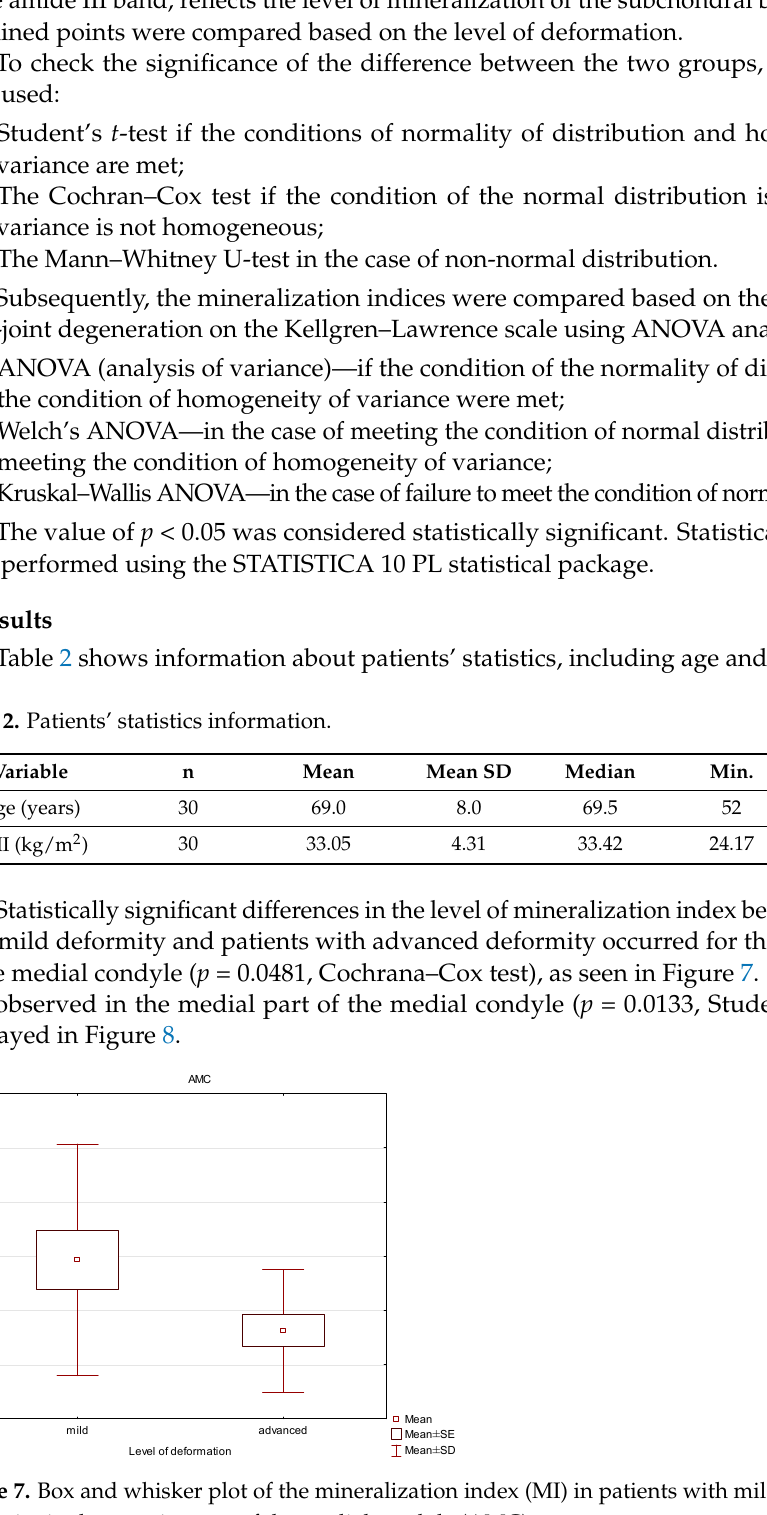
Figure 8. Box and whisker plot of the mineralization index (MI) in patients with mild and advanced deformity in the medial part of the medial condyle (MMC). Similar mineralization changes were observed in the anterior part of the lateral con- dyle ( p = 0.0251, Mann–Whitney U-test), as shown in Figure 9, and in the posterior part of the lateral condyle, presented in Figure 10 ( p = 0.0442, Student’s t -test).